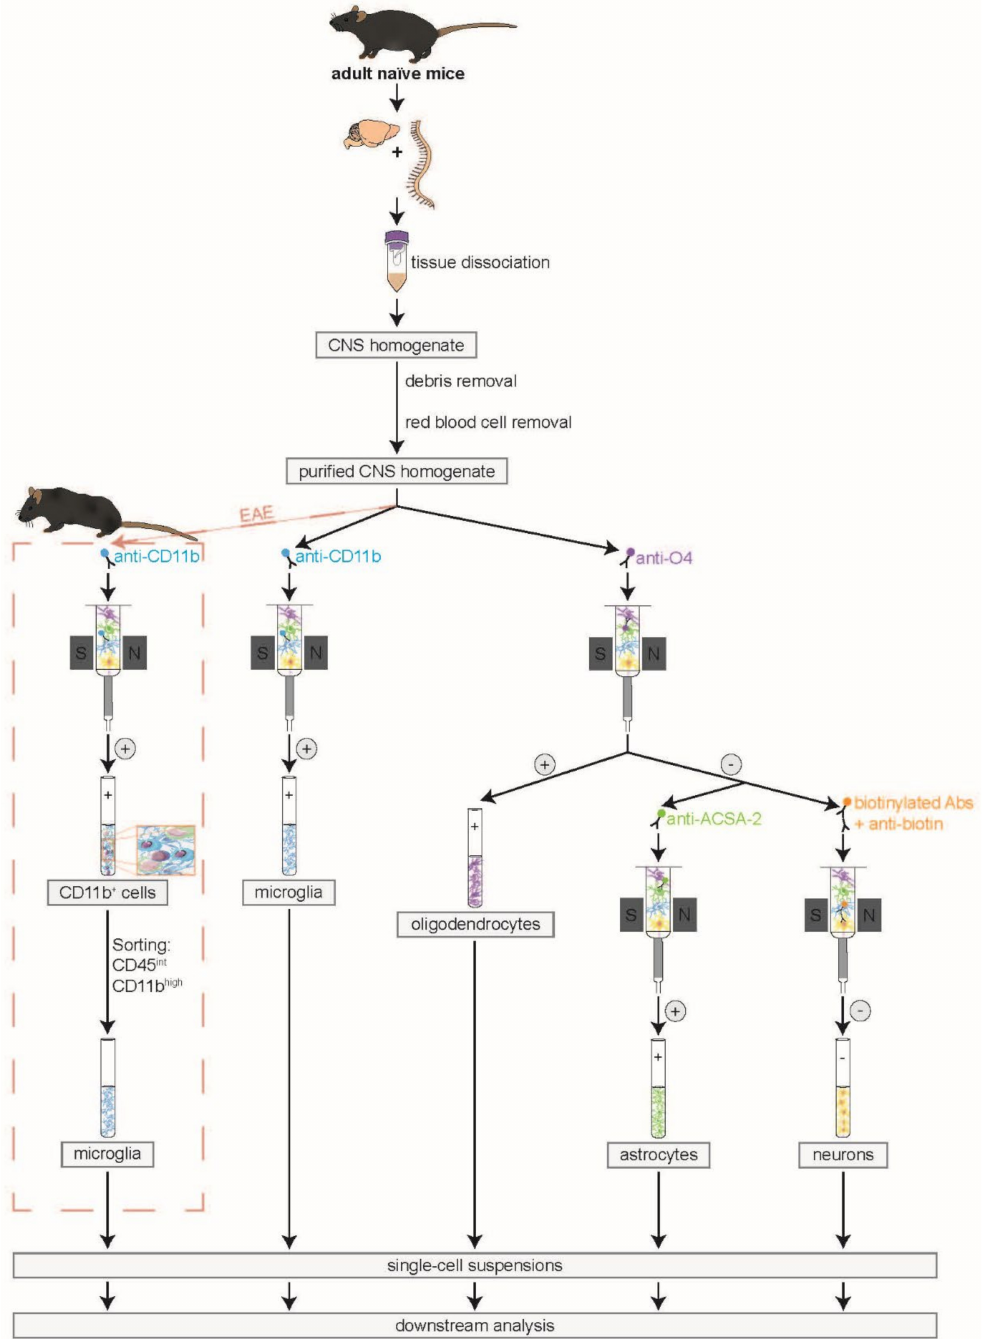
Figure 1. Workflow for simultaneous isolation of all principal CNS-resident cell types. First, the adult brain and spinal cord were dissected and dissociated. The resulting CNS homogenate was further modified by performing debris and red blood cell removal. The purified CNS homogenate was split into two fractions. One fraction was used for MACS of microglia via anti-CD11b MicroBeads (positive selection). Simultaneously, oligodendrocytes were isolated from the second cell fraction using anti-O4 MicroBeads (positive selection). Their negative flow-through was collected and used for the simultaneous isolation of astrocytes with anti-ACSA-2 MicroBeads (positive selection) and neurons by biotin labeling and depletion of all non-neuronal cells (negative selection). In experimental autoimmune encephalomyelitis (EAE) mice, the magnetic labeling of CD11b + cells had to be followed by fluorescence-activated cell sorting of CD45 int CD11b high cells in order to preserve purity at approximately 90%. Otherwise, CD11b + immune cells like monocytes, macrophages, dendritic cells, natural killer cells, and granulocytes would contaminate the microglia fraction since these cells are known to immigrate into the CNS during the EAE course